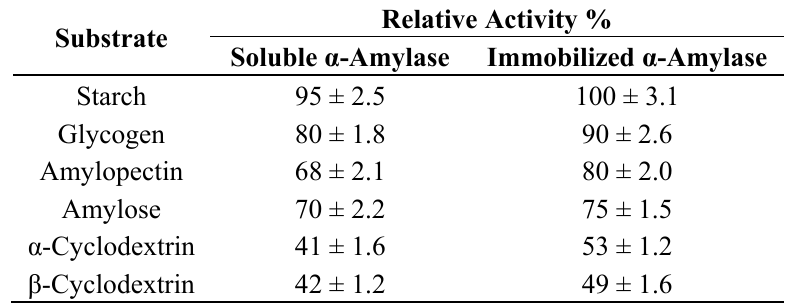
Table 2. The substrate specificity of soluble and immobilized α -amylases (1 unit).